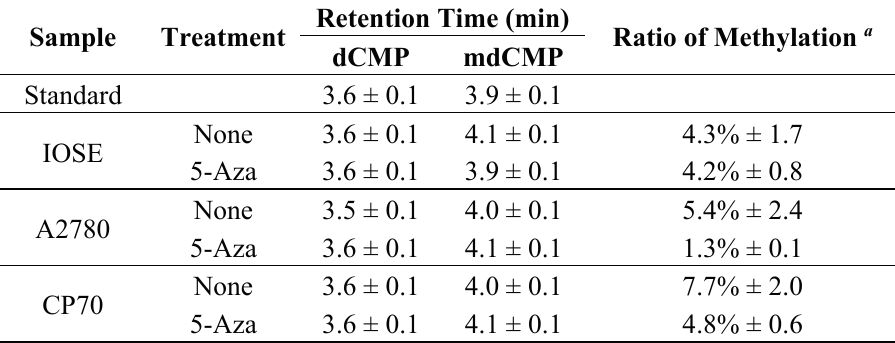
Table 1. Effect of 5-aza by high-performance liquid chromatography (HPLC) quantitation ovarian surface epithelium (IOSE), A2780 and CP70 cell